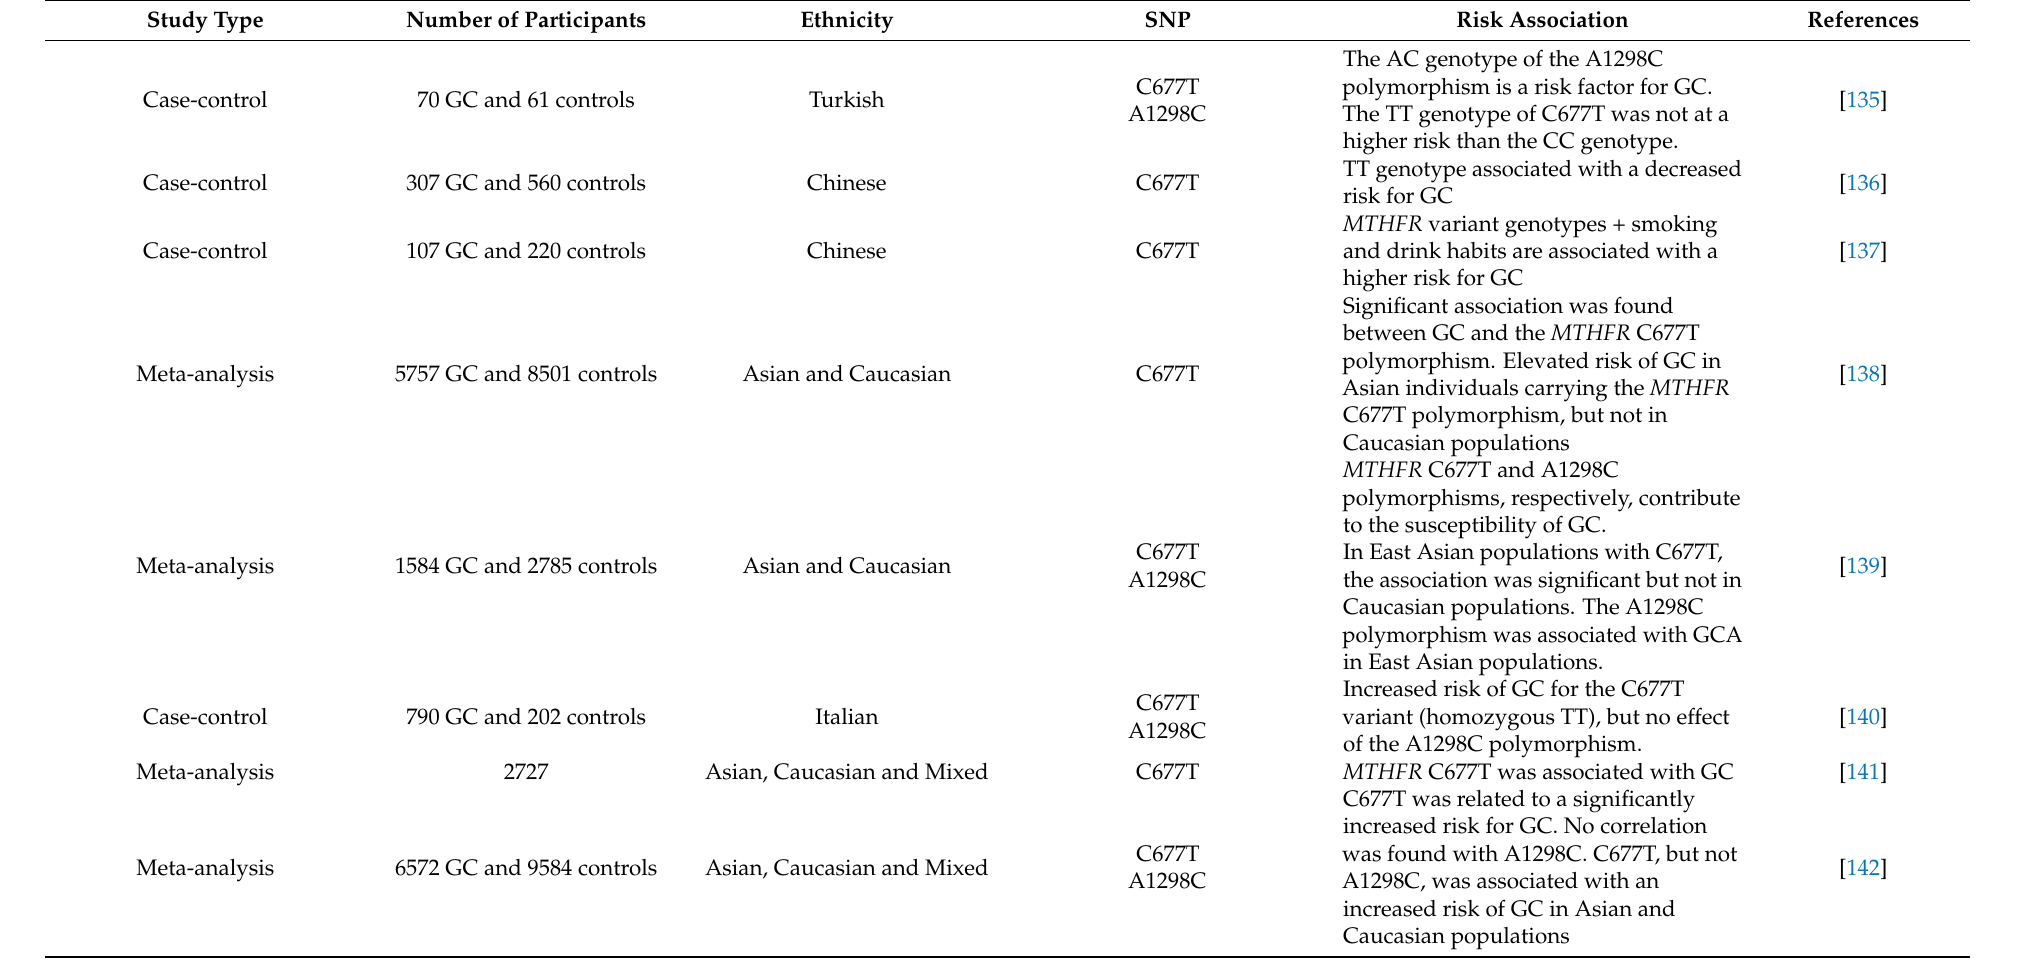
Table 3. Effect of the polymorphisms on gastric cancer